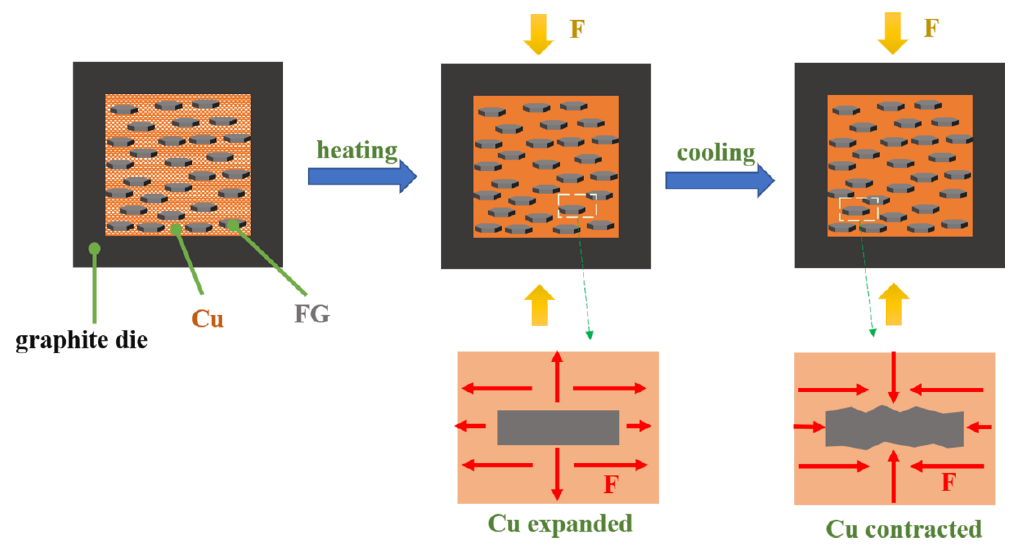
Figure 10. Wrinkles on the ( a ) surface and ( b ) inside of the FGs.